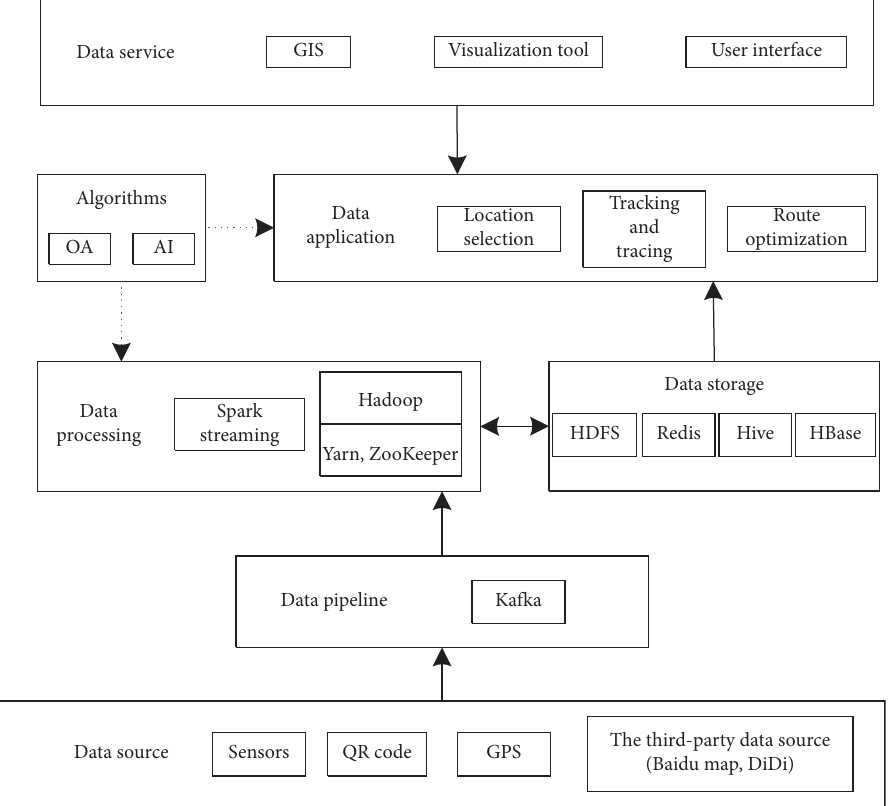
Figure 2: Architecture of the proposed big data